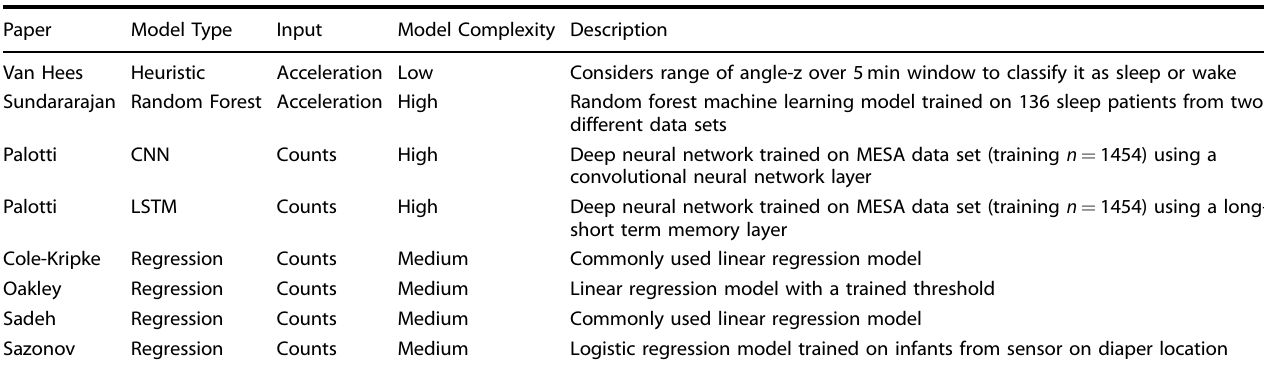
Table 3. Summary of the compared